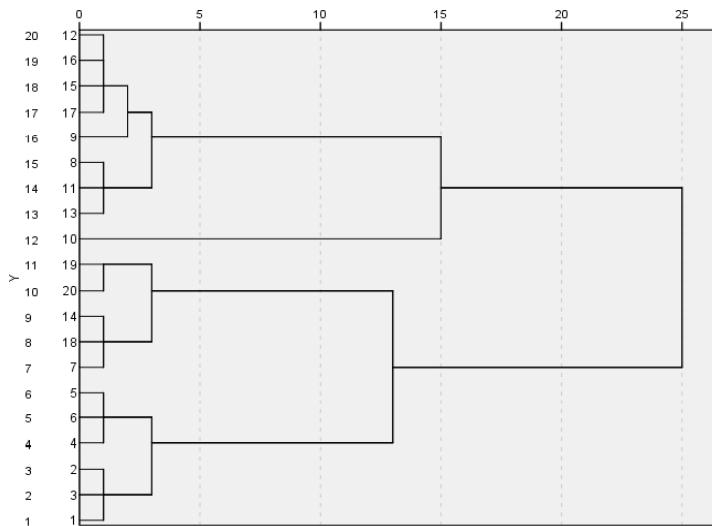
Figure 8. Cluster analysis pedigree of 20 turmeric samples.